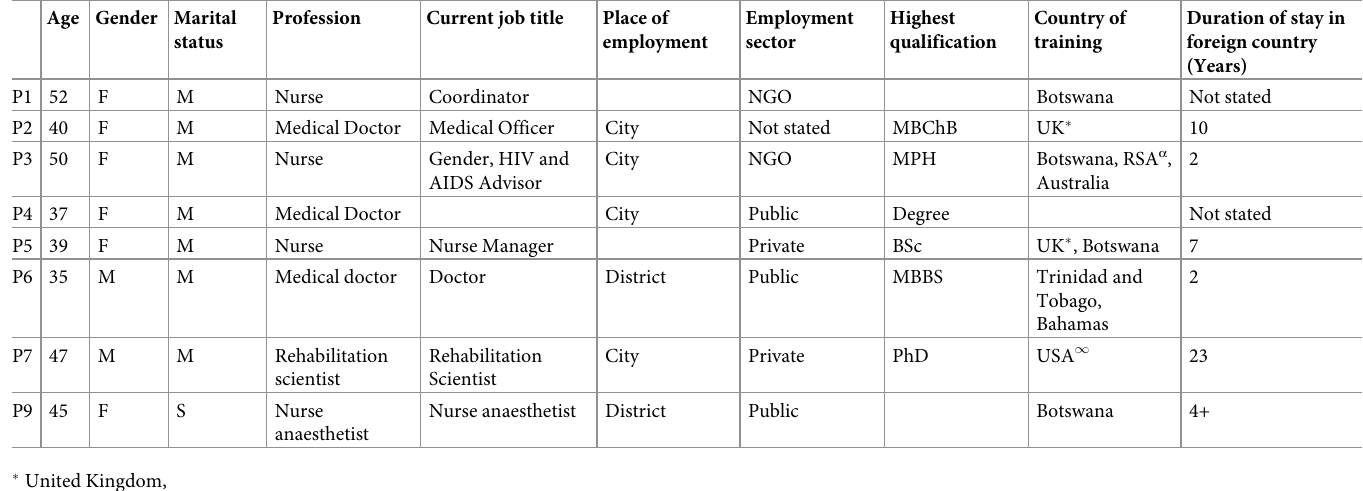
Table 1. Characteristics of study